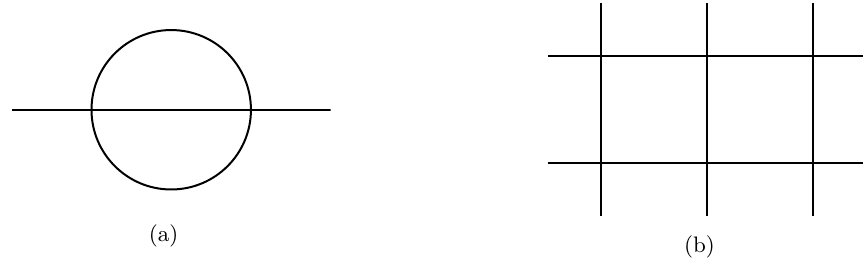
Figure 1 . The sunrise integral in two dimensions with unequal internal masses (a) as well as the ten-point double-box integral in four dimensions with massless internal propagators